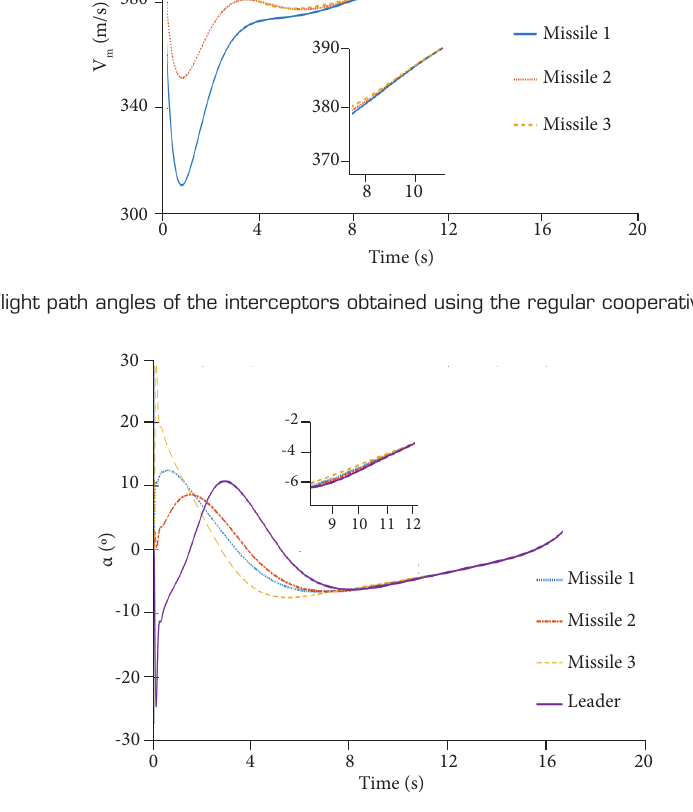
Figure 11. AOA curves of the interceptors obtained using the regular cooperative control